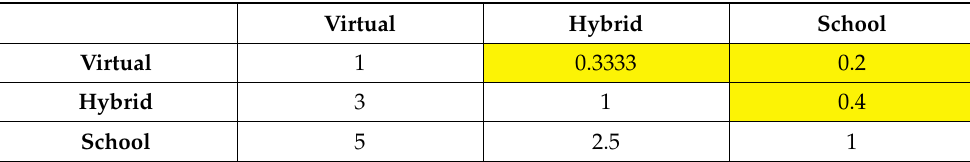
Table 5. Pairwise Comparison and Weights for the 3 Alternatives under the Education Criterion. Virtual Hybrid School Virtual 1 0.3333 0.2 Hybrid 3 1 0.4 School 5 2.5 1